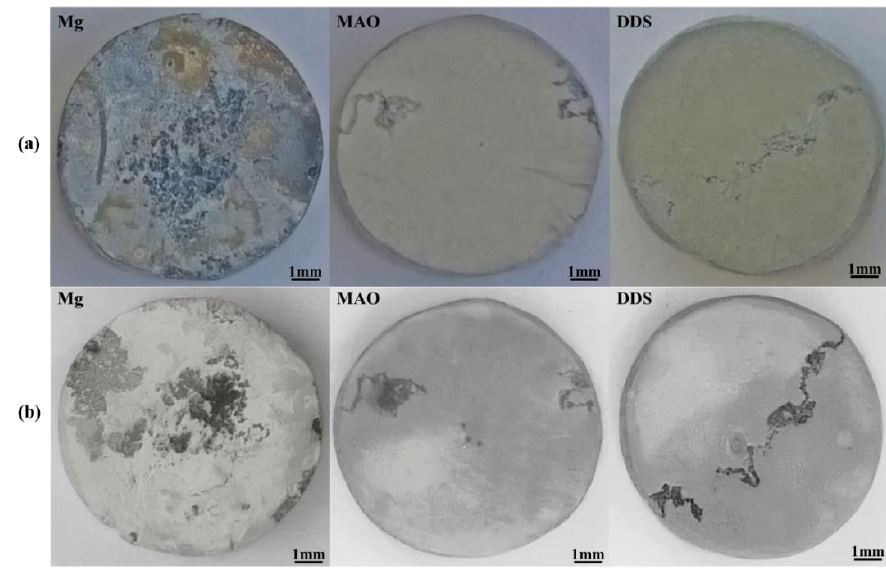
Figure 4. The surface macro morphologies of Mg alloy, Mg-based MAO alloy, and Mg-based MAO- MT-PLGA DDS before pickling ( a ) and after pickling ( b ) with the picric acid solution after immersion in Hank’s solution for 28 days.